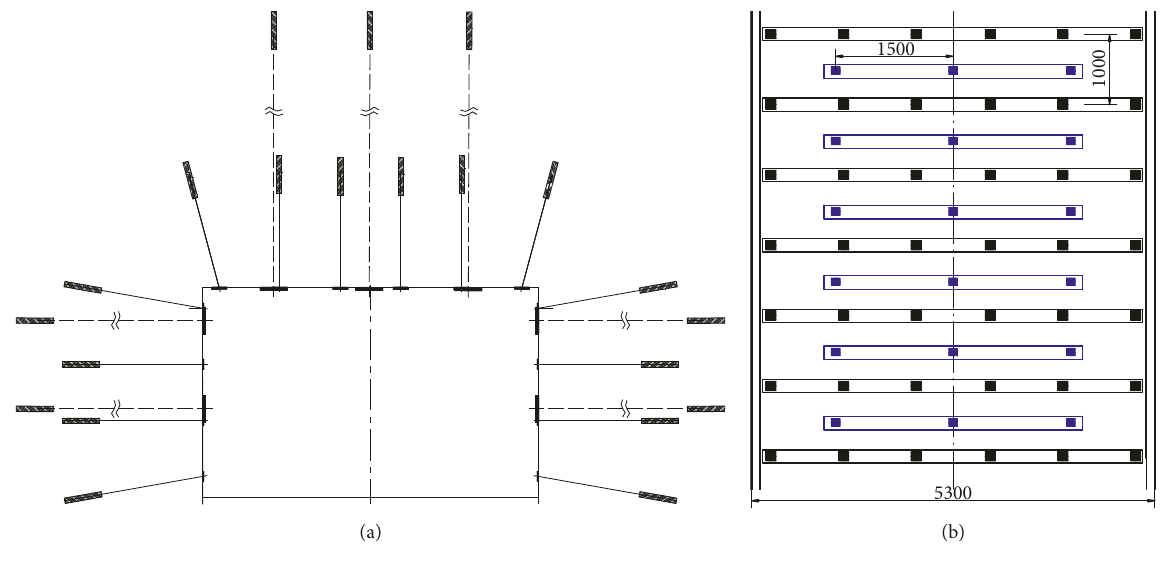
Figure 11: Sketch of air return